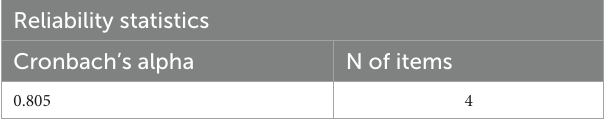
TABLE 3 Results of reliability analysis.